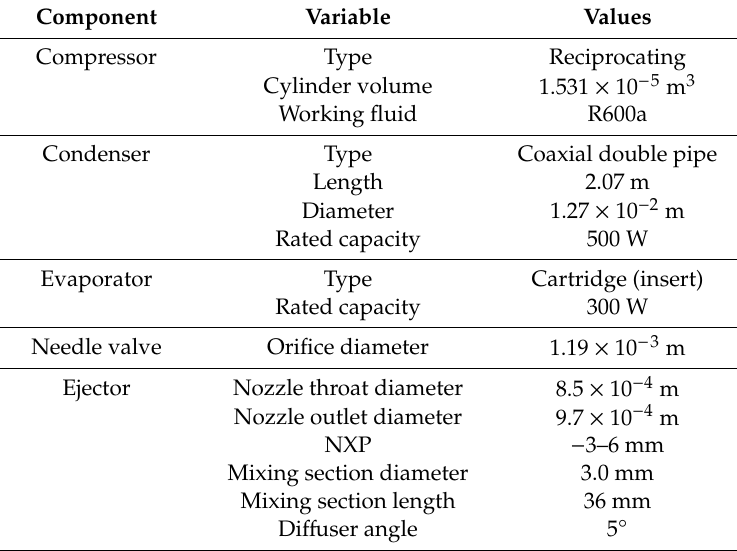
Table 1. Specifications of system components and tested ejector.